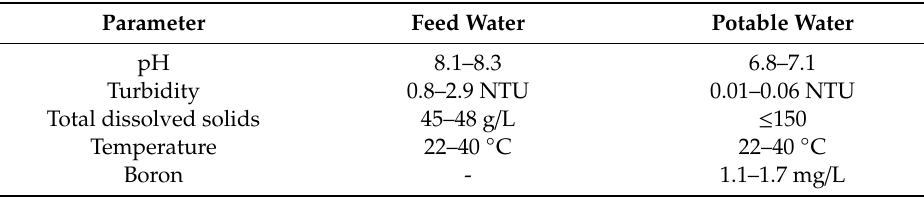
Table 2. The water properties of influent and potable